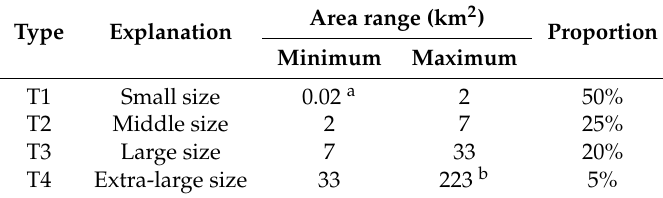
Table 2. Four di ff erent types of MCBs.